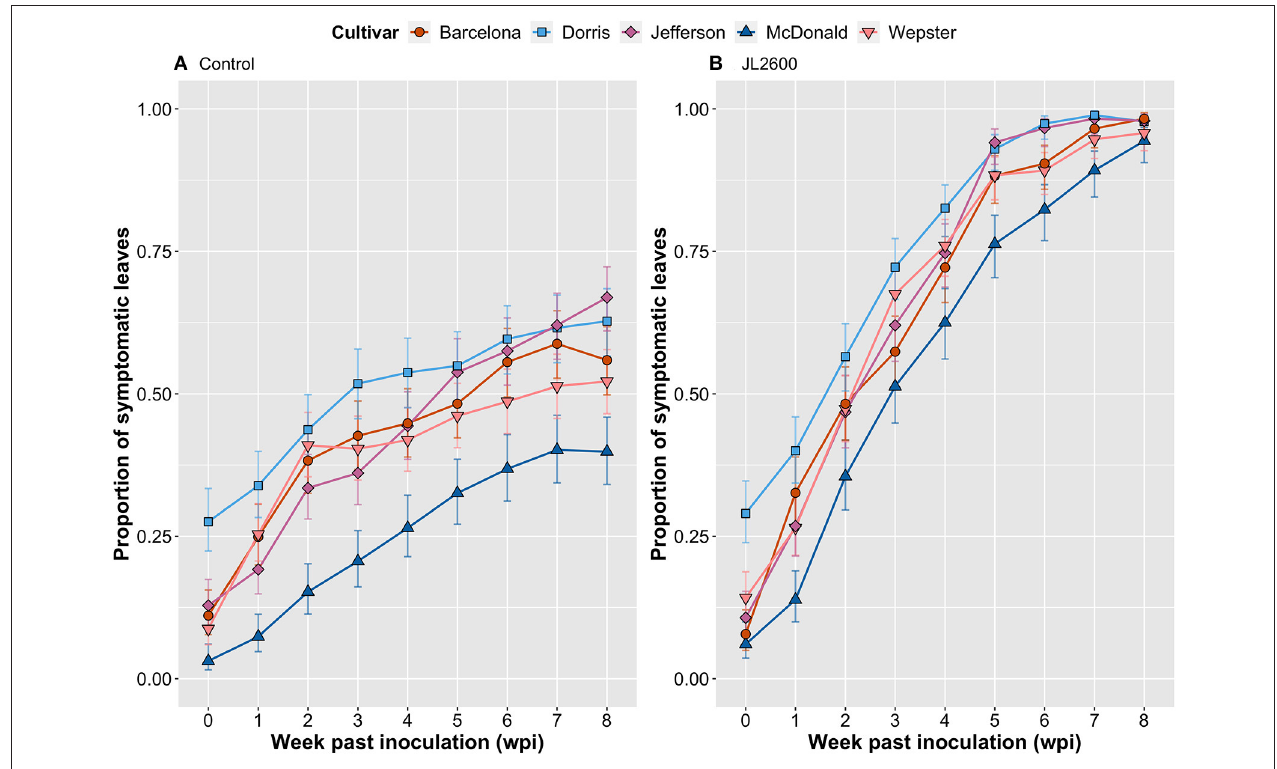
FIGURE 3 | Comparison of host responses over an 8-week evaluation period of five cultivars of hazelnut, propagated as tissue cultured explants on water-agar medium, and dip inoculated with sterile-deionized water [ (A) . Control], or the hazelnut bacterial blight pathogen Xanthomonas arboricola pv. corylina strain JL2600 [ (B) . JL2600]. Data points represent the proportion of total leaves on an explant that were symptomatic. Vertical bars represent 95%